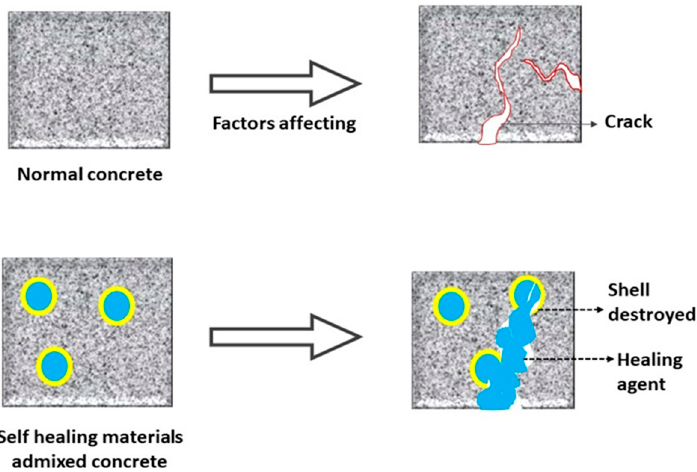
Figure 12. Illustration of the self-healing mechanism in